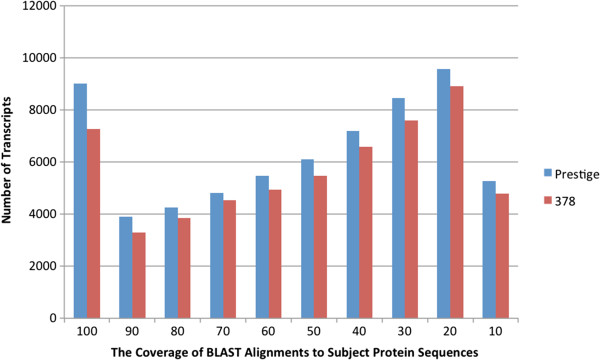
The number of transcripts versus the coverage of blast alignments to subject protein sequences.